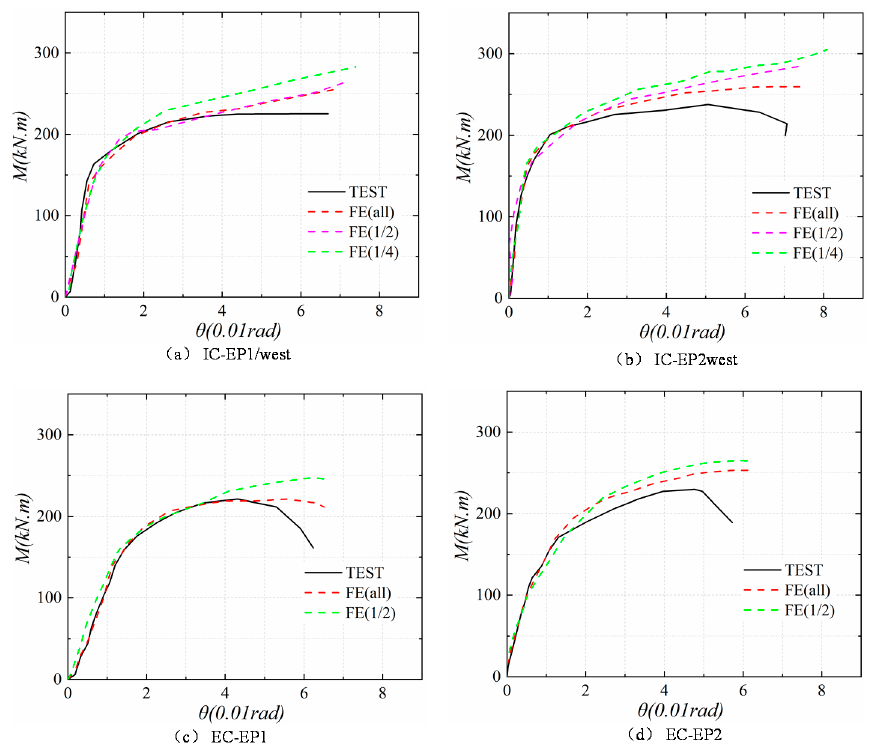
Figure 21. M– θ skeleton curves ( a ) IC-EP1 west; ( b ) IC-EP2 west; ( c ) EC-EP1; ( d ) EC-EP2. Table 8. Comparison of the FE analysis and test results.